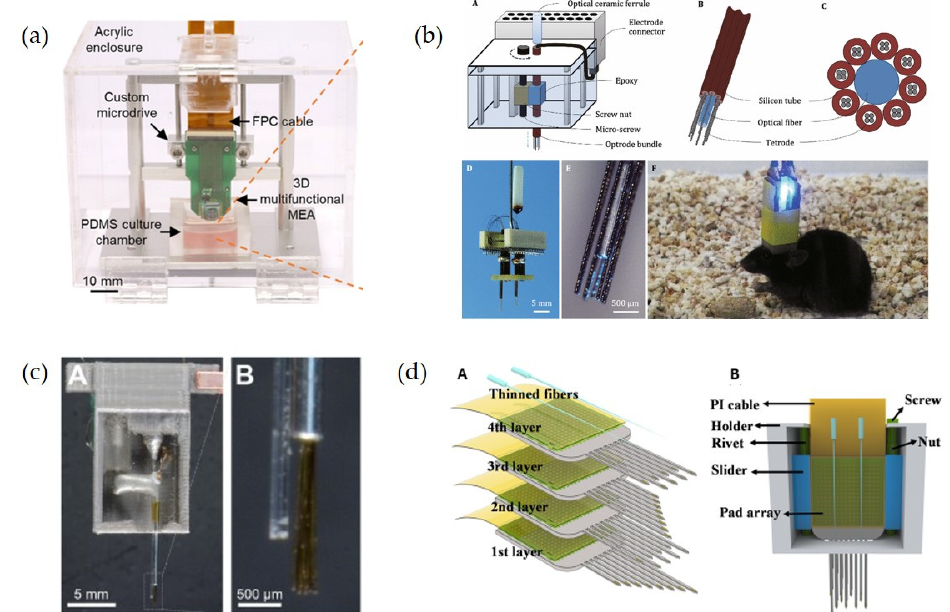
Figure 3. Several types of three-dimensional drivable optoprobes. ( a ) Photograph of the 3D opto-